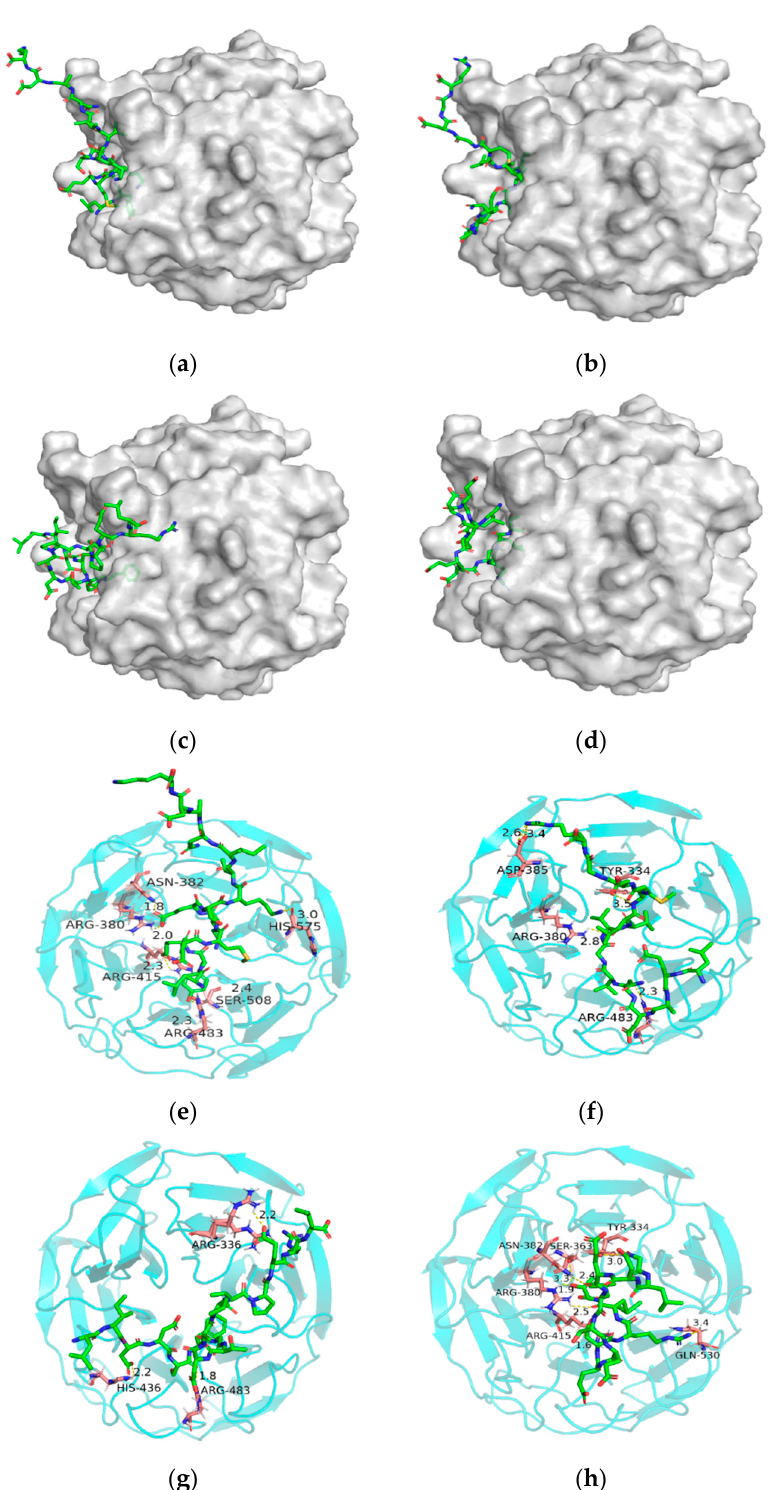
Figure 5. Molecular docking results of LYEEMKESKVINADK ( a , e ), LEADNVGVVLMGDGR ( b , f ), LIDDSFGTDAPVPERL ( c , g ), GLDELSEEDRLT ( d , h ). ( a – d ) reflect the surface docking simulations between the peptides and Keap1, and ( e – h ) reflect the peptides binding with amino acid residues in the Keap1 activity center.